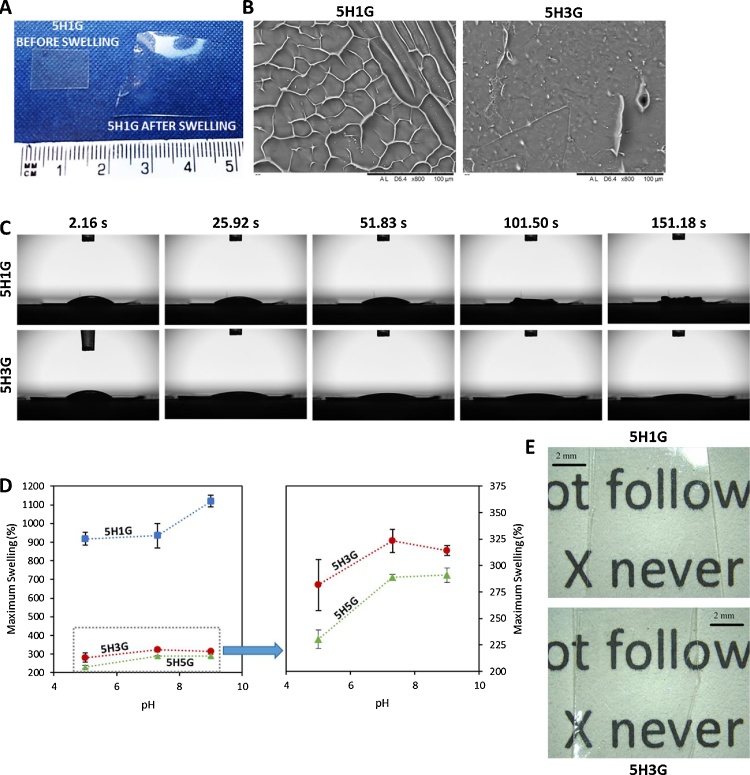
Photography of dry and swollen 5H1G hydrogels (A). SEM micrography of freeze dried hydrogels (B). Pictures showing the water uptake of 5H1G and 5H3G hydrogels as a function of the time (C). Maximum swelling as a function of the pH for different HA/GAN hydrogels (D). (Means ± S.D; n = 3). Photograph of dry films (E).